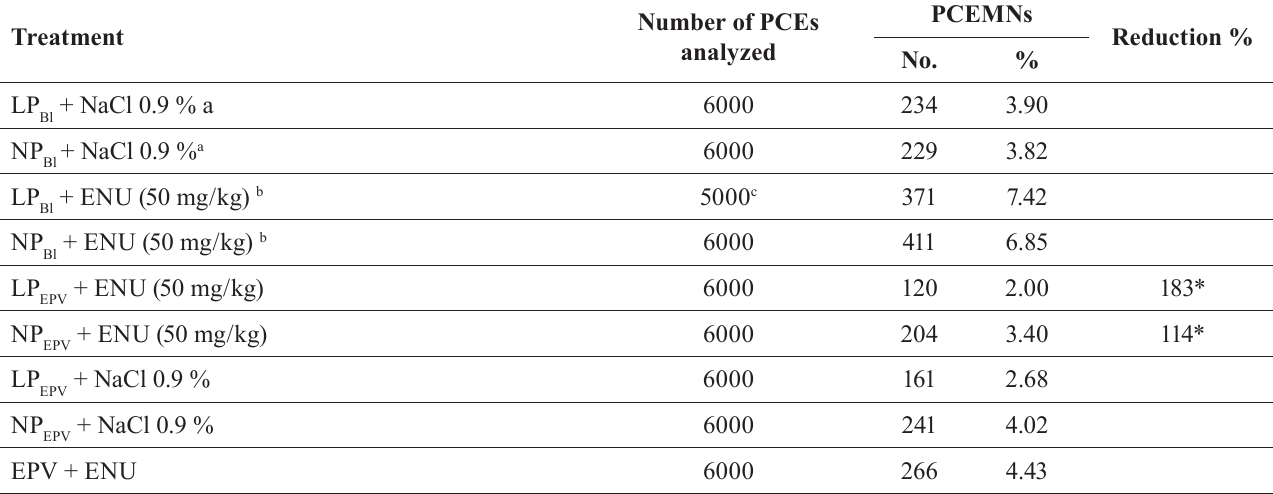
PCEMNs Number of PCEs Reduction % analyzed No. %